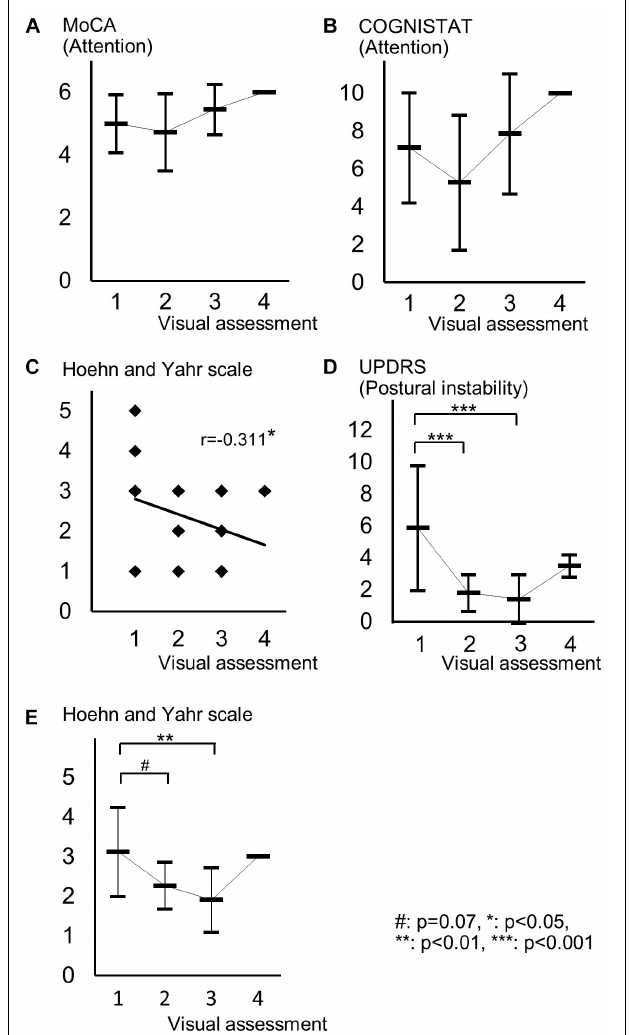
FIGURE 4 | Distribution of cognitive and motor assessment scores for each visual assessment grade. (A) Mean and standard deviation of MoCA subscore of attention in each visual grade. (B) Mean and standard deviation of COGNISTAT subscore of attention in each visual grade. (C) Distribution of Hoehn and Yahr scale and visual grade. (D) Mean and standard deviation of postural instability score in each visual grade. (E) Mean and standard deviation of Hoehn and Yahr scale in each visual